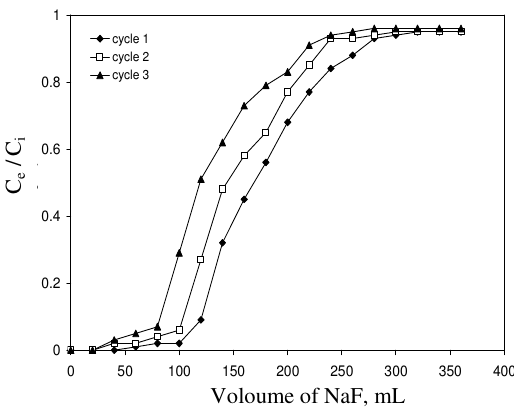
Figure 3. Column breakthrough curves for adsorption of fluoride on PCA. Table 1. Adsorption capacities of column breakthrough curves for fluoride adsorption.